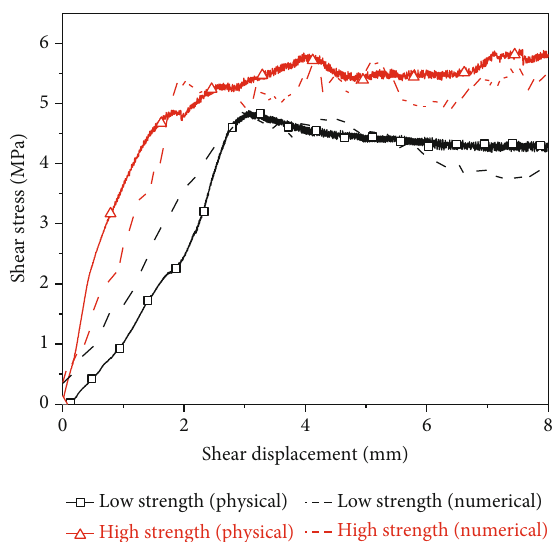
Figure 7: Shear stress-shear displacement curves of shear of indoor experiments and numerical